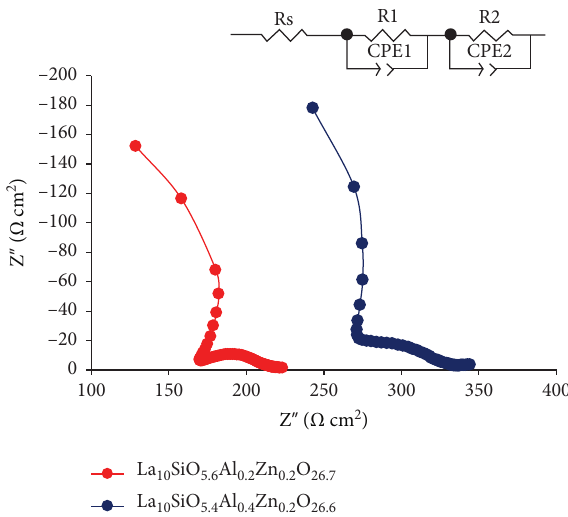
Figure 5: A.C. impedance plots of La 10 Si 5.6 Al 0.2 Zn 0.2 O 26.7 (left) and La 10 Si 5.4 Al 0.4 Zn 0.2 O 26.6 (right) at intermediate operating temperature of 800 ° C and the equivalent circuit. Table 2: Total conductivity of different compositions reported in this work and in the literature. Sample compositions